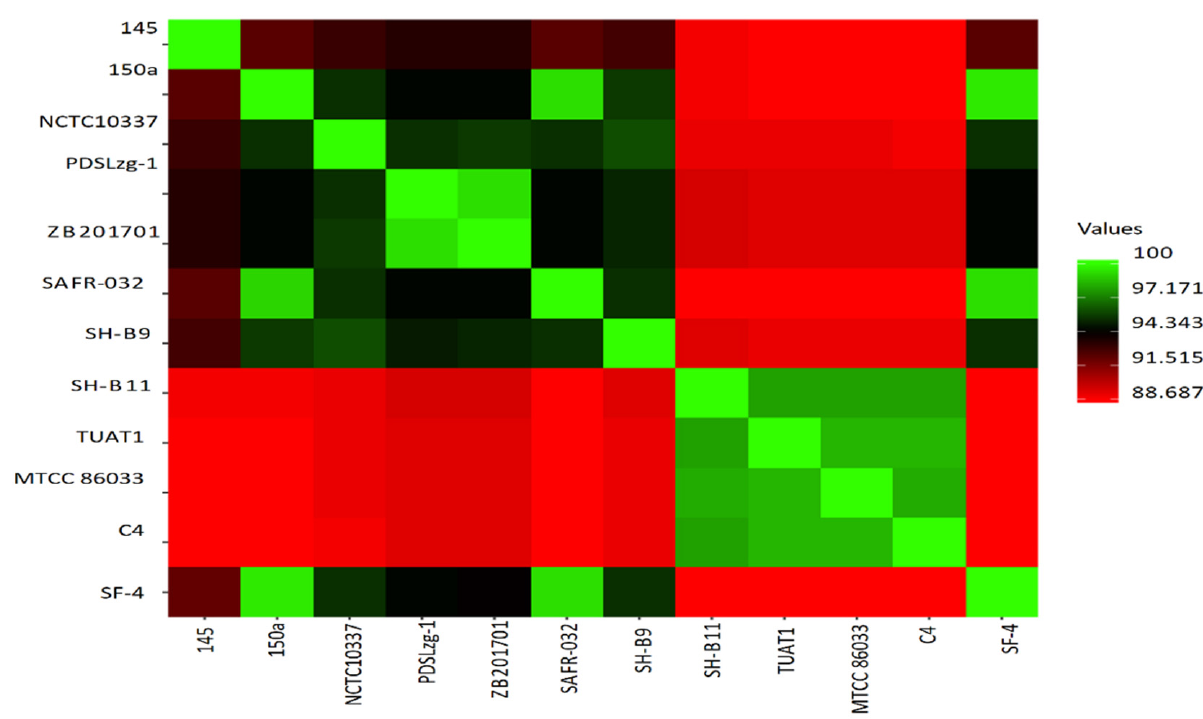
Figure 6. A heatmap representing the degree of similarity shared by 12 B. pumilus genomes based on average nucleotide identity (ANI) values. The map was derived from ANI matrix determined from low (dark red) to high (light green) similarities among genomes.